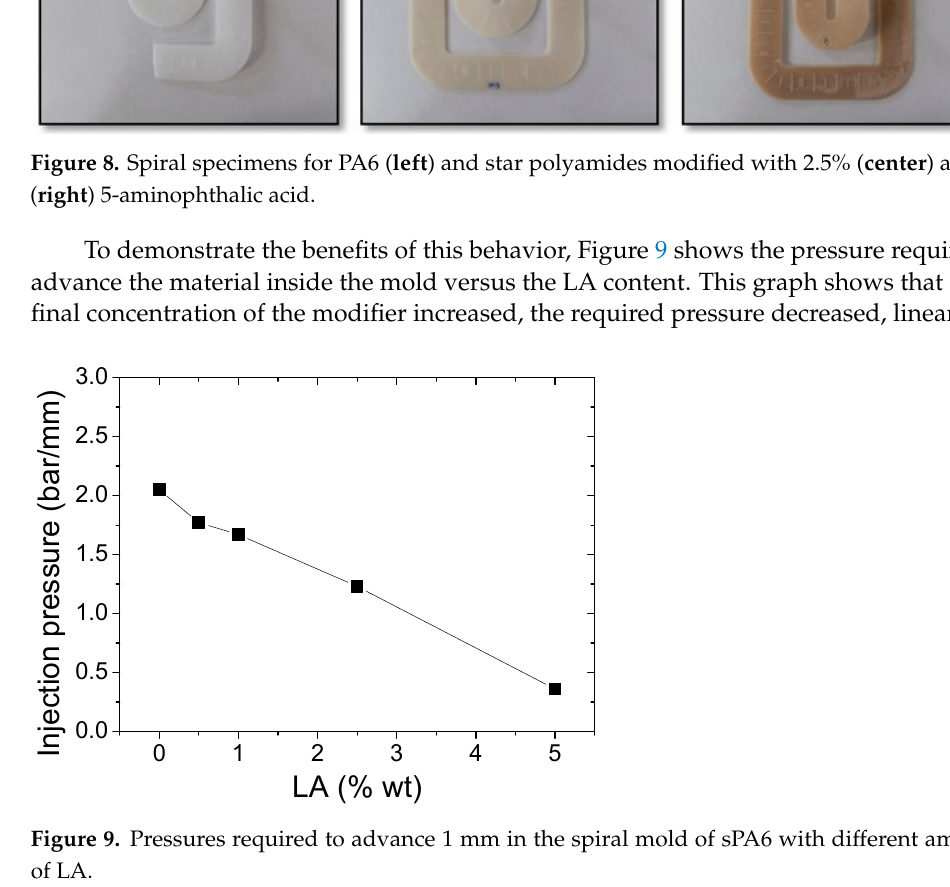
Figure 9. Pressures required to advance 1 mm in the spiral mold of sPA6 with different amounts of LA.